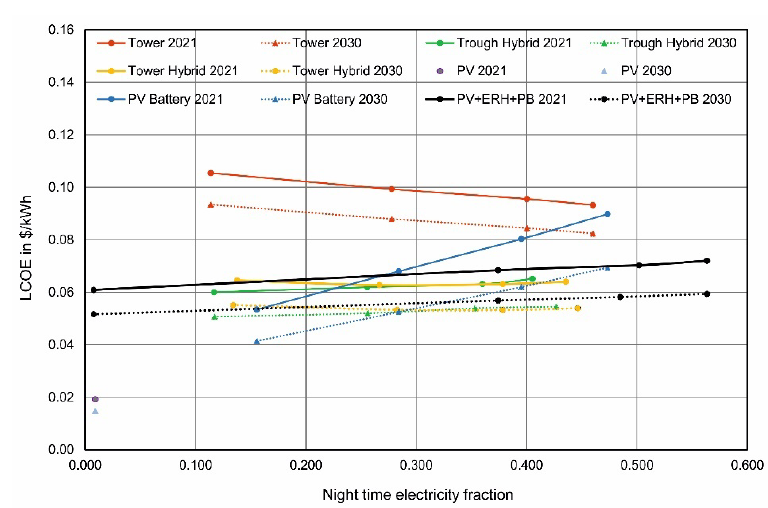
Figure 11. Projections for Riyadh 2030.